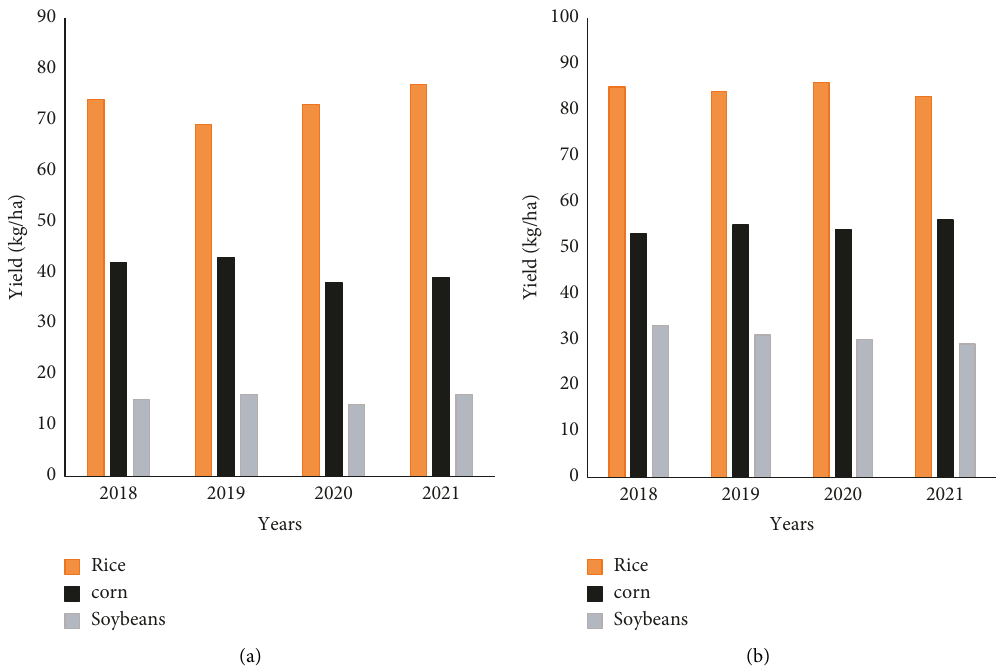
Figure 7: The yield of traditional crops and synthetic crops in different years.